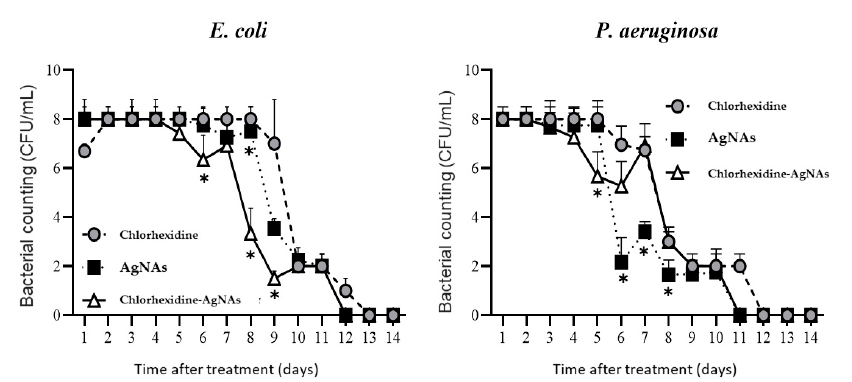
Figure 5. Wound microbiological profile at different times after treatment with chlorhexidine, chlorhexidine–AgNAs, and AgNAs solutions. *—significant difference from the control (chlorhexidine) groups ( p ≤ 0.05).